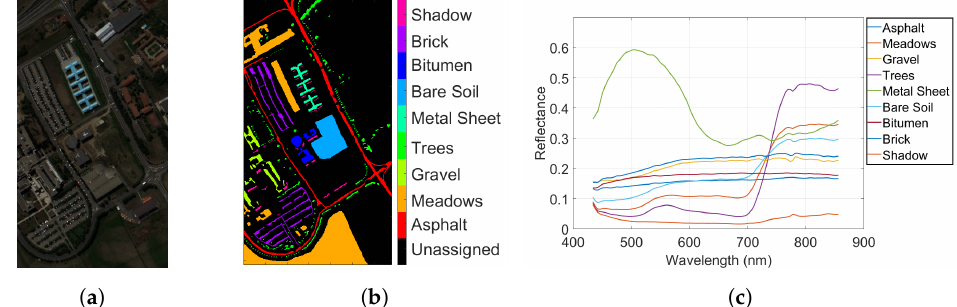
Figure 12. ROSIS Pavia University ( a ) true-color composite; ( b ) reference class map; ( c )